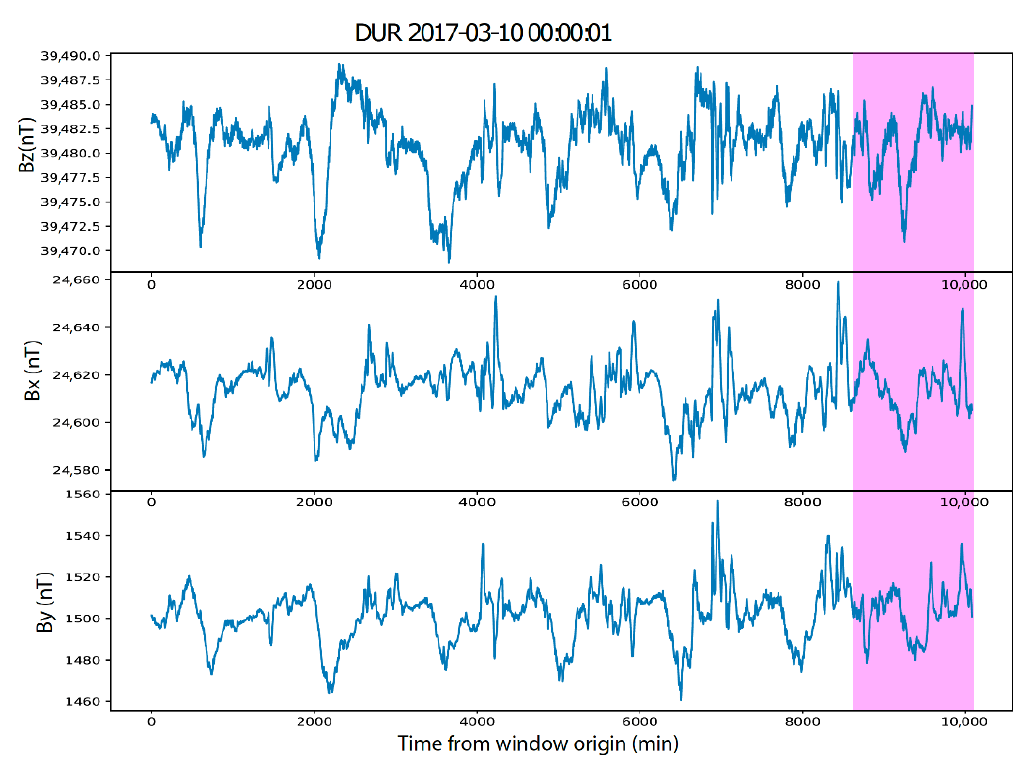
Figure 2. One-week-long geomagnetic field recordings at the Duronia (DUR) observatory in Italy. The three components show the amplitude of the geomagnetic field in the vertical direction (Bz) and the horizontal directions (Bx for north – south and By for east – west). The shaded pink region shows a one-day-long window.